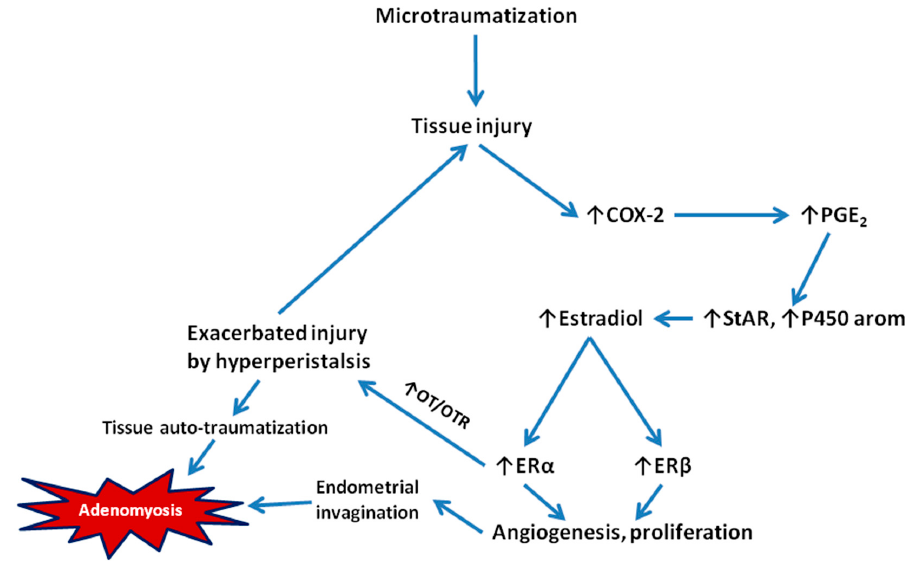
Figure 2. Leyendecker’s model of tissue injury and repair (TIAR) that initiates the genesis of adenomyotic lesions [29,30]. Briefly, microtraumatization in the endometrial–myometrial interface causes tissue injury, which subsequently induces upregulation of COX-2 and increased production of PGE 2 , which, in turn, induces the expression of genes critical to estrogen production such as StAR and aromatase, resulting in increased local estrogen production. The elevated estrogen levels would activate both ER α and ER β , leading to the induction of the OT / OTR signaling and subsequent increased uterine peristalsis and increased angiogenesis and proliferation. The increased peristalsis would further exacerbate uterine hyperperistalsis and thus TIAR, causing endometrial invagination and ultimately the formation of adenomyotic lesions. Gene / protein names: COX-2: cyclooxygenase-2; E 2 : 17 β -estradial; ER α : estrogen receptor α ; ER β : estrogen receptor β ; IL-1 β : interleukin-1 β ; P450 aromatase: aromatase; OT: oxytocin; OTR: oxytocin receptor; PGE 2 : prostaglandin E2; StAR: steroidogenic acute regulatory